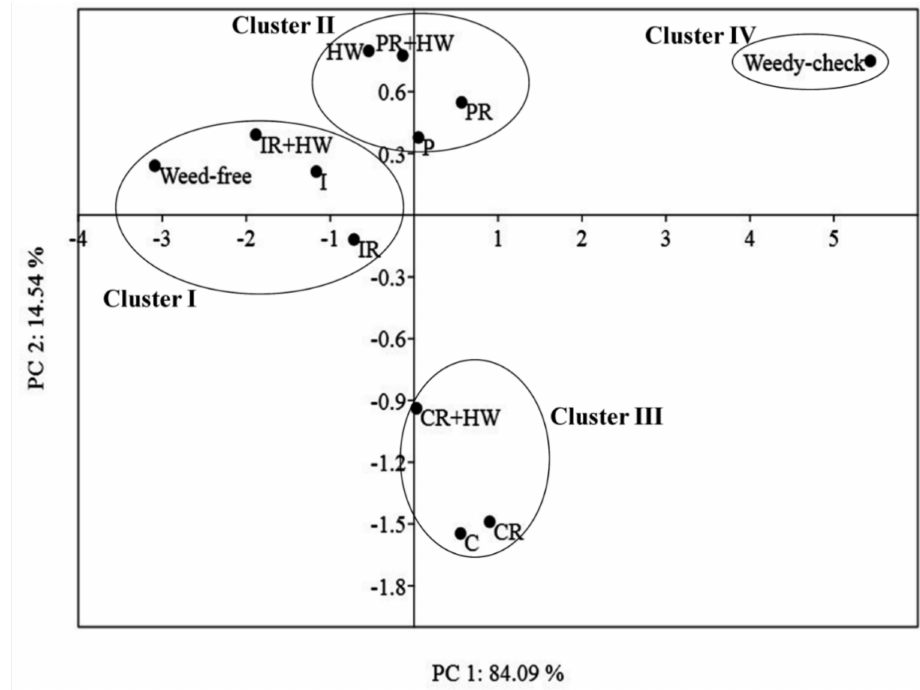
Figure 5. Principal component analysis of weed and yield data. PC 1 and PC 2 jointly explained 98.63% of the total